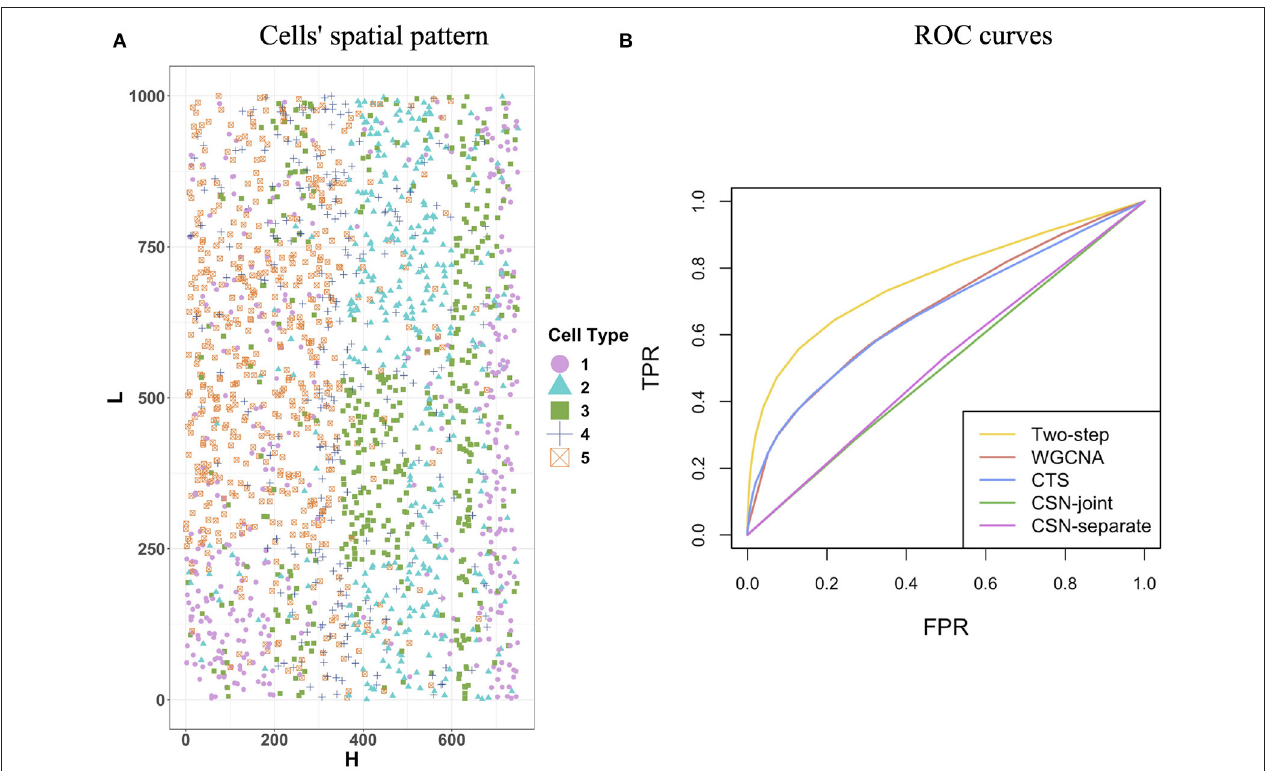
FIGURE 2 | Cells’ spatial pattern and performance comparisons on the network structure recovery. (A) Cells’ spatial pattern. Different shapes and colors correspond to different types of cells. (B) ROC curves of the two-step algorithm, WGCNA, CTS, CSN-joint, and